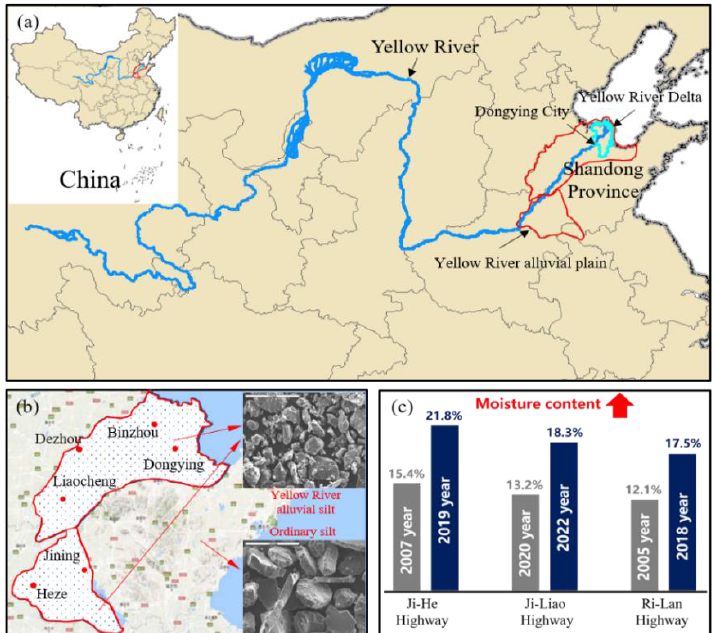
Figure 1. ( a ) The location and area of YRAP, ( b ) distribution of alluvial silts and ( c ) subgrade moisture variation of three Highways located in YRAP.